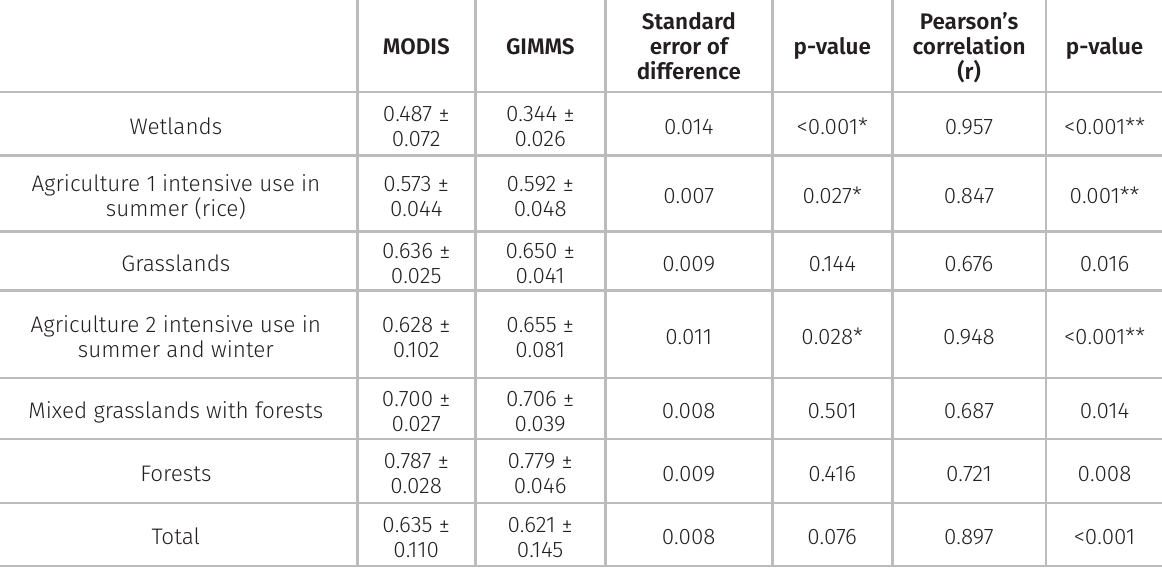
Table II. Comparison of measurement by paired T test and Pearson’s correlation between the mean annual NDVI for MODIS and GIMMS for each homogeneous region of vegetation cover in Rio Grande do Sul - Brazil and respective